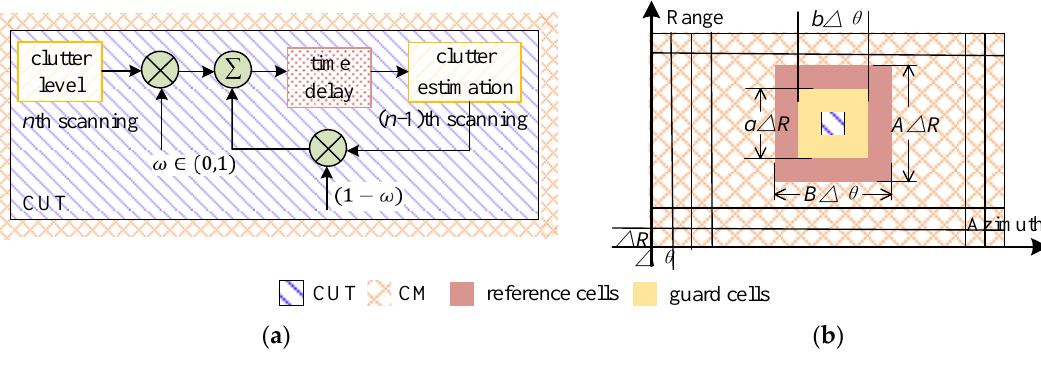
Figure 2. The estimations of clutter level at the cell under test (CUT) during CM-constant false alarm rate (CFAR) processing: ( a ) The ‘point’ technique of Nitzberg CM-CFAR; ( b ) The plane technique used in the hybrid CM-CFAR.